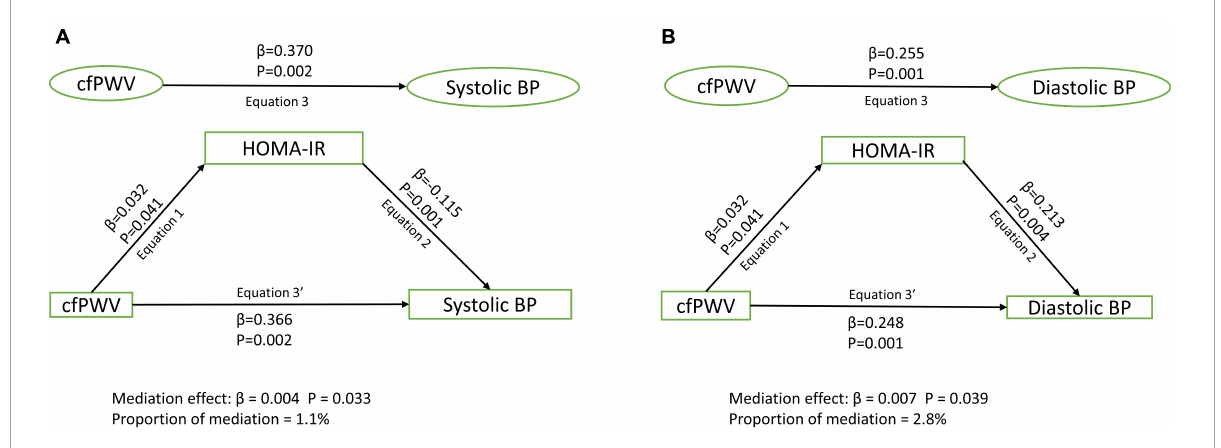
FIGURE3 Mediating role of insulin resistance on the associations of arterial stiffness with systolic blood pressure (A) and diastolic blood pressure (B) . Mediating path analyses were adjusted for age, sex, high-density lipoprotein cholesterol, low-density lipoprotein cholesterol, triglyceride, high-sensitivity C reactive protein, family history of hypertension and cardiovascular diseases, smoking status, heart rate, fat mass, and lean mass. BP, blood pressure; cfPWV, carotid-femoral pulse wave velocity; HOMA-IR, homeostatic model assessment of insulin resistance.